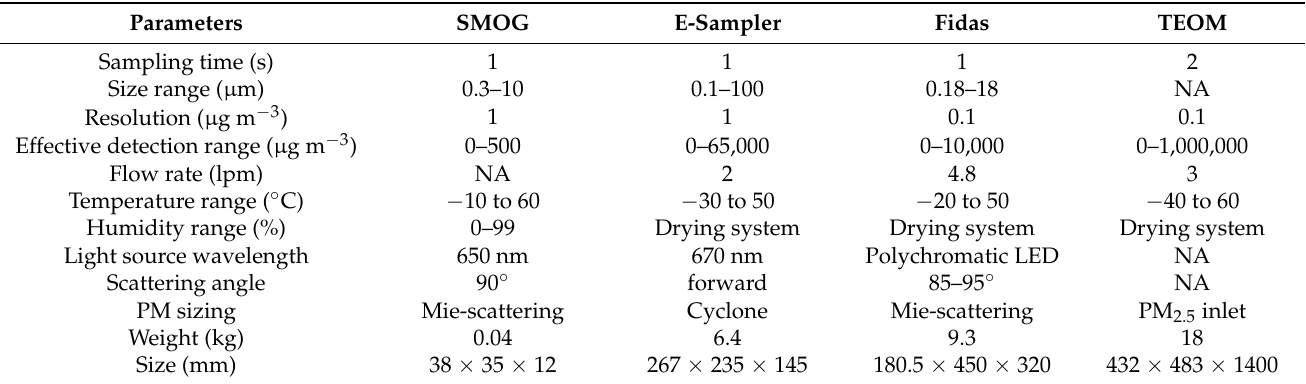
Table 1. Operational settings of